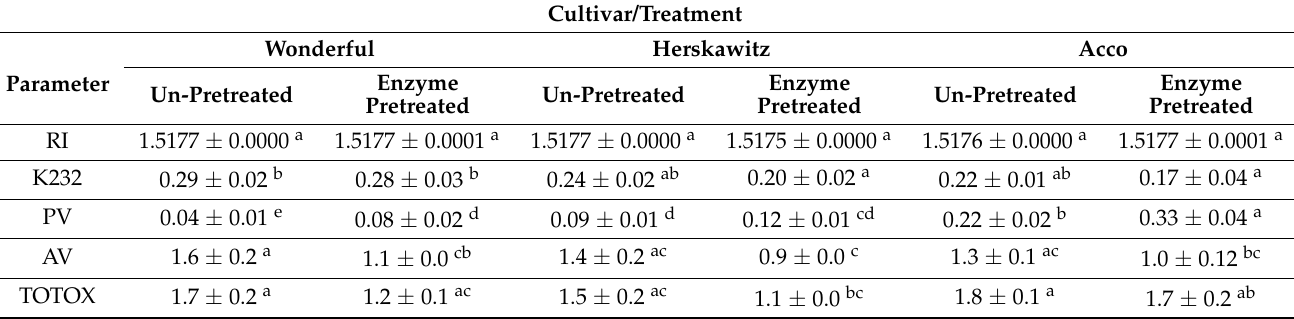
Table 1. Physicochemical properties of un-pretreated and enzyme pretreated seeds (1.7%, 40 °C, pH = 4.5 and 5 h) from selected pomegranate cultivars.